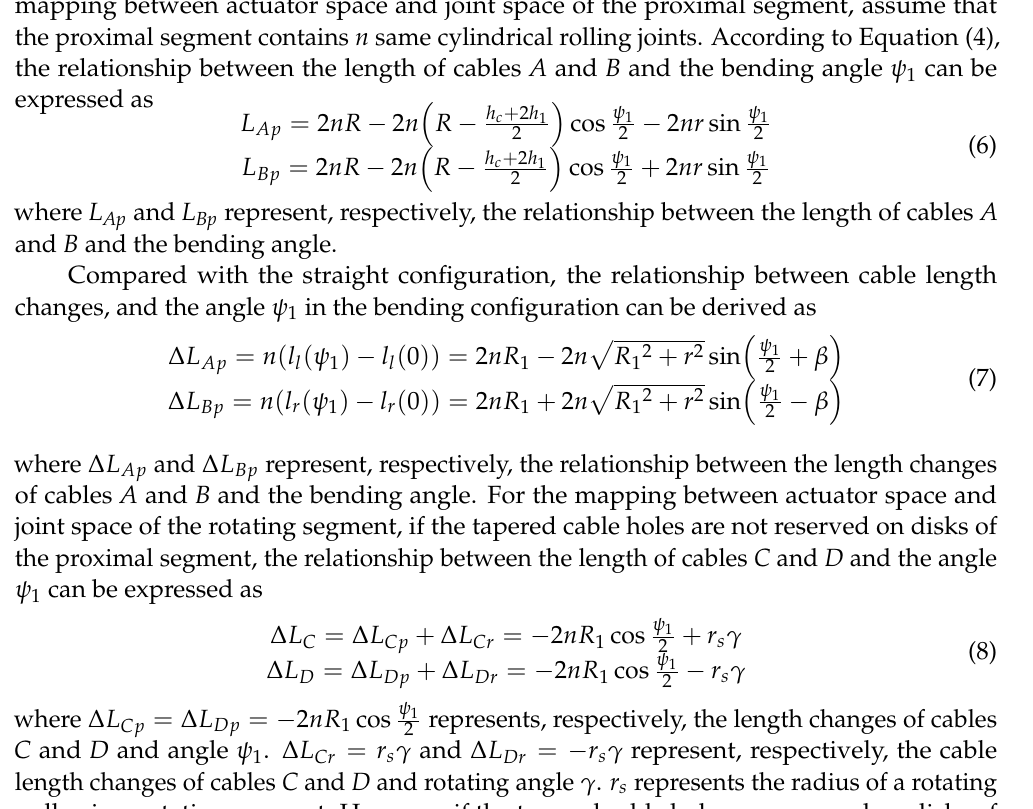
Table 1. The main specific parameters of the robot. Symbols Descriptions Values The initial distance between the major axes of h c adjacent ellipses r Cable distribution circle radius 9 mm R Cylindrical rolling radius 10.5 mm w c The distance between the two focuses of the ellipse 10 mm ψ The angle of joint bending [ − π /9, π /9] The distance between the circle center and the upper h 0 surface of the lower disk The distance between the major axis and the upper h 1 surface of the lower disk h 2 The thickness of a single disk 11.5 mm h 3 The initial height of the single joint 11.0 mm The distance between the circle center and the upper h 4 surface of the lower disk